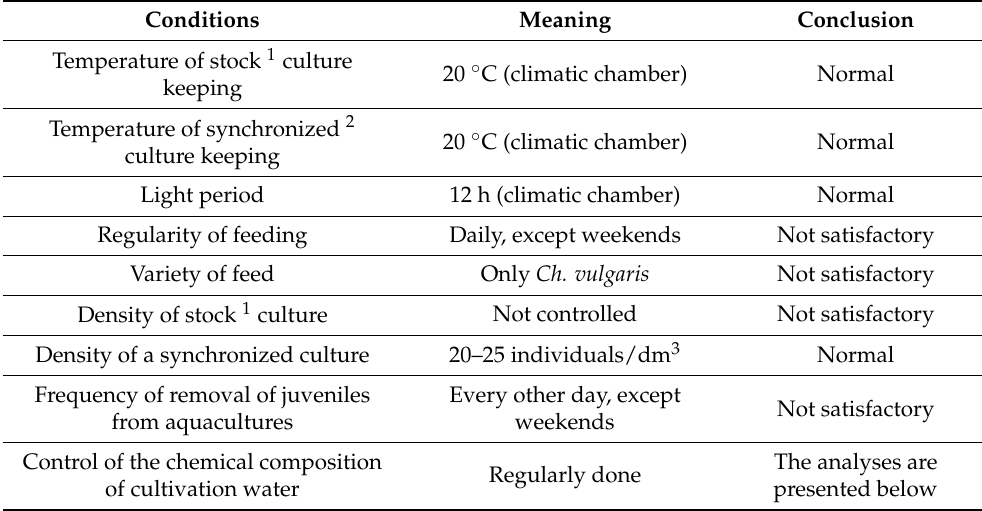
Table 3. Analysis of abiotic and biotic conditions of D. magna in Laboratory No.